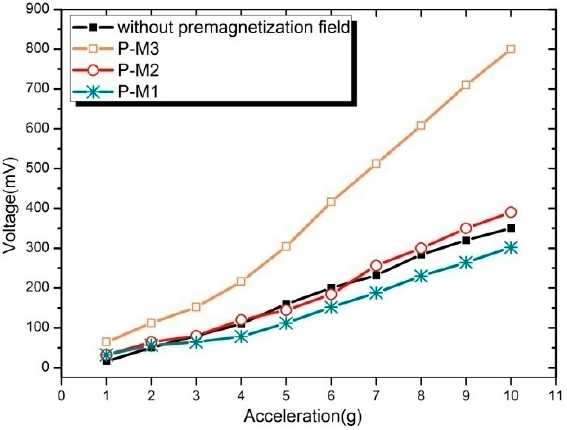
Figure 18. Voltage of the harvester without and with pre-magnetized magnet.